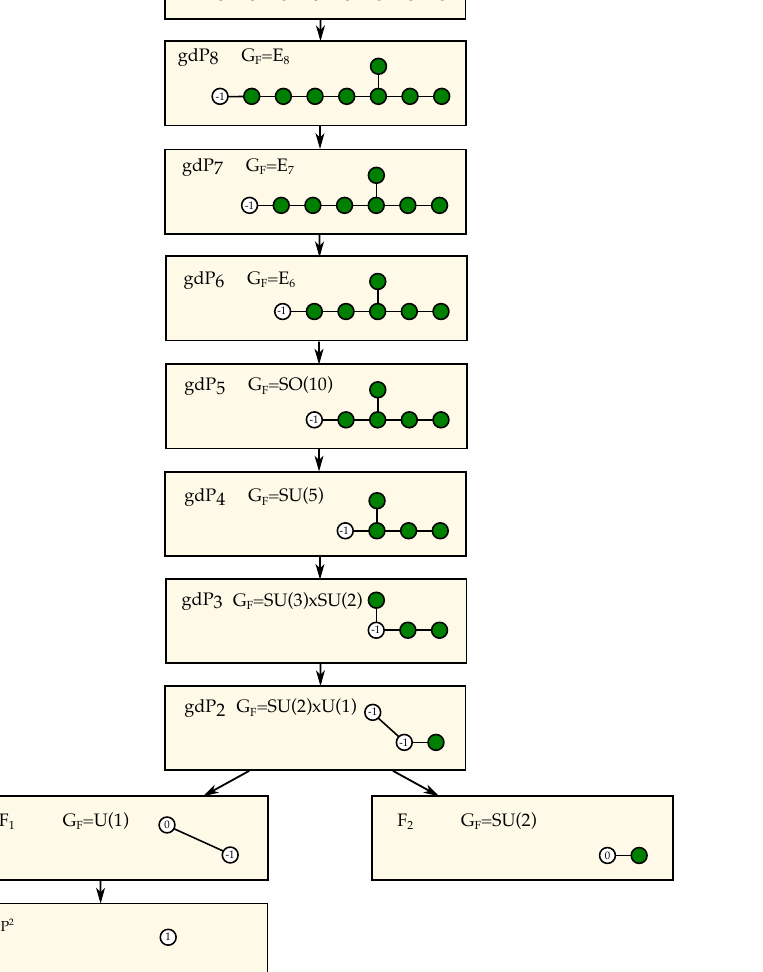
Figure 10 . Rank one CFD tree starting with the marginal CFD, given by the gdP 9 , including all ( (cid:0) 2)-curves (shown in green) as well as one ( (cid:0) 1)-curve. The transitions are dictated by the rules in De(cid:12)nition 4.2. The strongly coupled (cid:13)avor symmetry is denoted by G F and the non-abelian